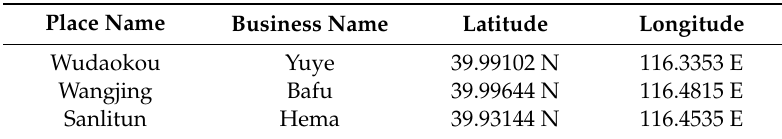
Table 2. Business data from